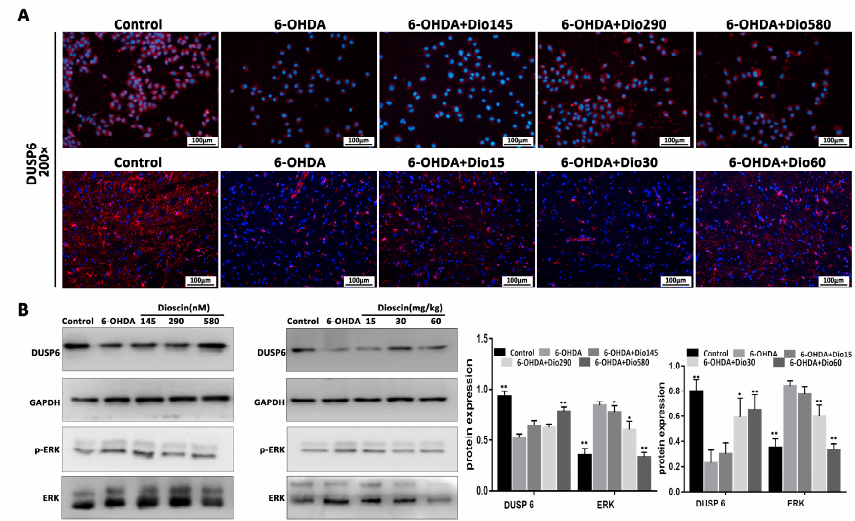
Figure 6. Effects of dioscin on dual-specificity phosphatase 6 (DUSP6) and phospho-extracellular regulated protein kinases (p-ERK) expression levels. ( A ) Effects of dioscin on the expression levels of DUSP6 in cells and rats by immunofluorescence assay ( × 200 magnification). ( B ) Western blot assays of the expression levels of DUSP6 and p-ERK/ ERK in PC12 cells and rats. Data are expressed as the mean ± SD ( n = 3). * p < 0.05 and ** p < 0.01 compared with the 6-OHDA group.